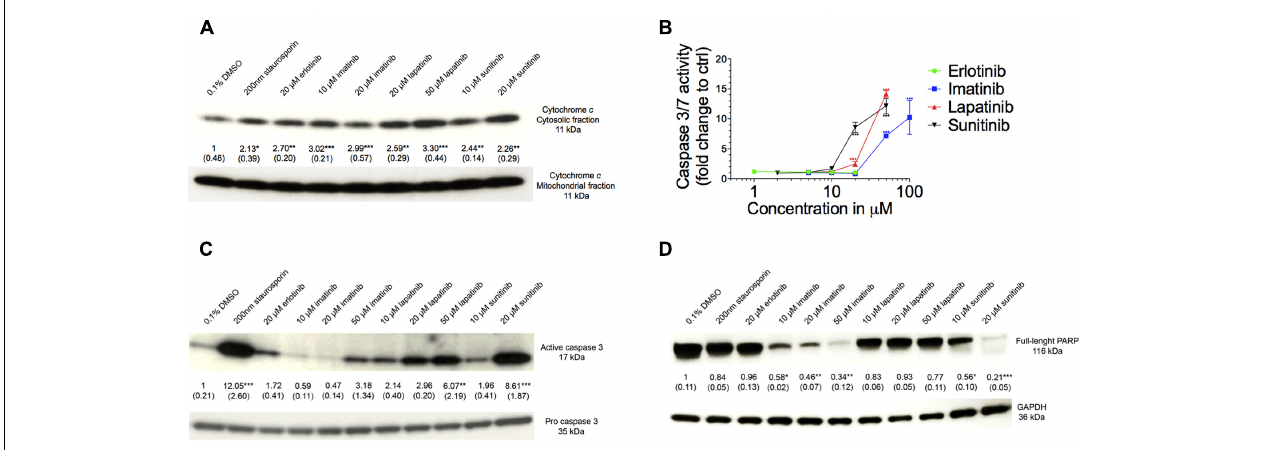
FIGURE 7 | Assessment of apoptosis. (A) Western blot analysis of the ratio of expression of cytochrome c in the cytosolic to mitochondrial fraction. (B) Caspase 3/7 activity in HepG2 cells after drug exposure for 48 h. (C) Western blot analysis of the expression of active to pro caspase 3. (D) Western blot analysis of the expression of full length PARP. All data are expressed as fold change to control incubations containing 0.1% DMSO. Data represent the mean ± SEM of at least three independent experiments. ∗ p < 0.05, ∗∗ p < 0.01 or ∗∗∗ p < 0.001 versus DMSO